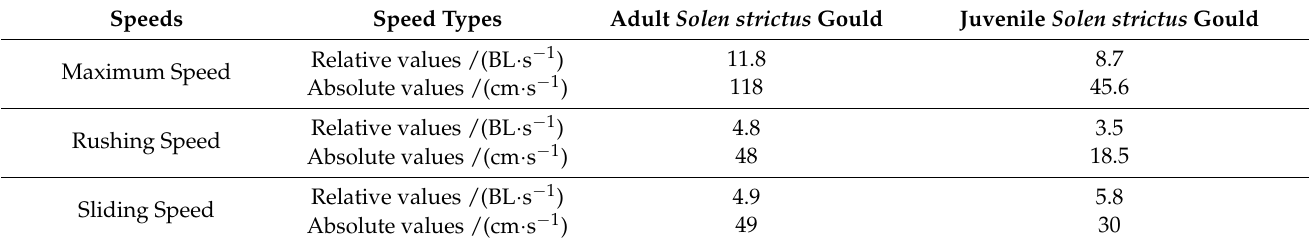
Table 1. Speed and acceleration time of Solen strictus Gould.